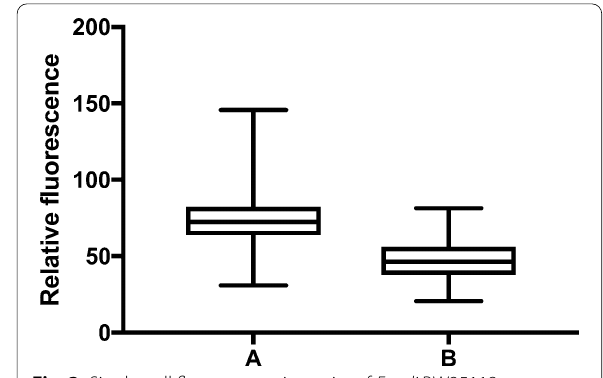
Fig. 3 Single-cell fluorescence intensity of E. coli BW25113 expressing mScarlet red fluorescent protein under the control of the ( A ) tolC promoter and ( B ) soxS promoter. The bar in the box depicts the median and the bar above and below the box shows the maximum and minimum values